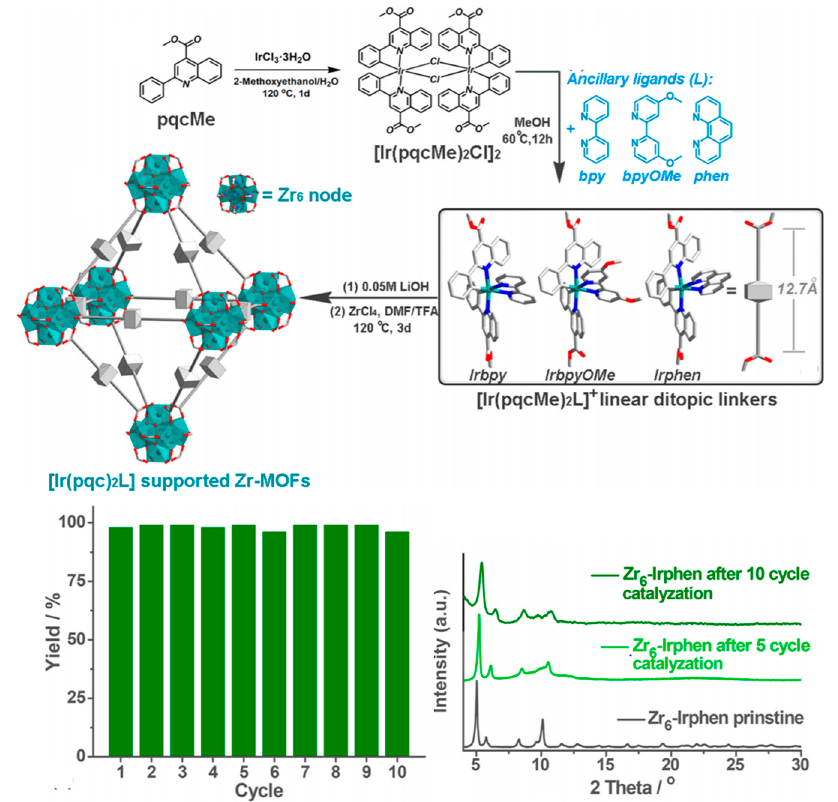
Figure 12. Structural design and photocatalytic application of Zr–Ir–MOFs into sulfoxidation processes. Adapted with permission from Reference [35], Copyright (2019) American Chemical Society.